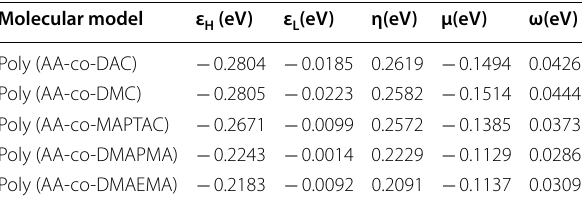
Fig. 4 Intensity autocorrelation function of Poly (AA‑co‑DAC) ( a ), Poly (AA‑co‑DMC) ( b ), Poly (AA‑co‑MAPTAC) ( c ), Poly (AA‑co‑DMAPMA) ( d ) and Poly (AA‑co‑DMAEMA) ( e ) at pI